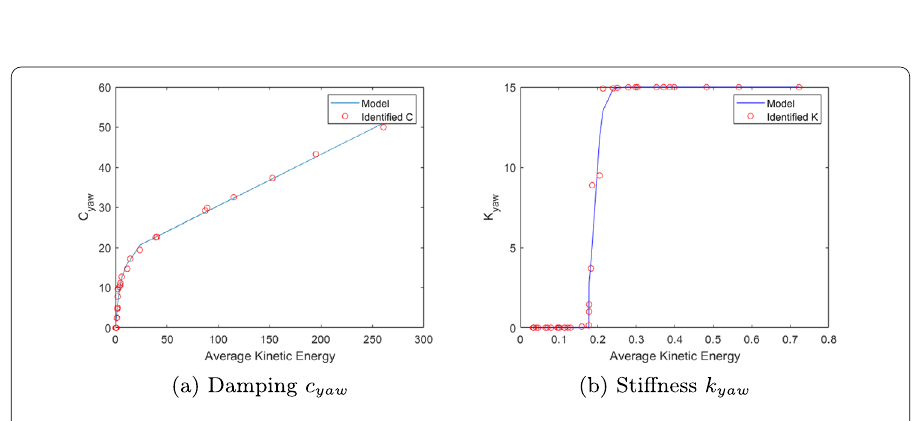
Figure 15 Damping and stiffness for the yaw axis against the fitted model of Equations (81) and